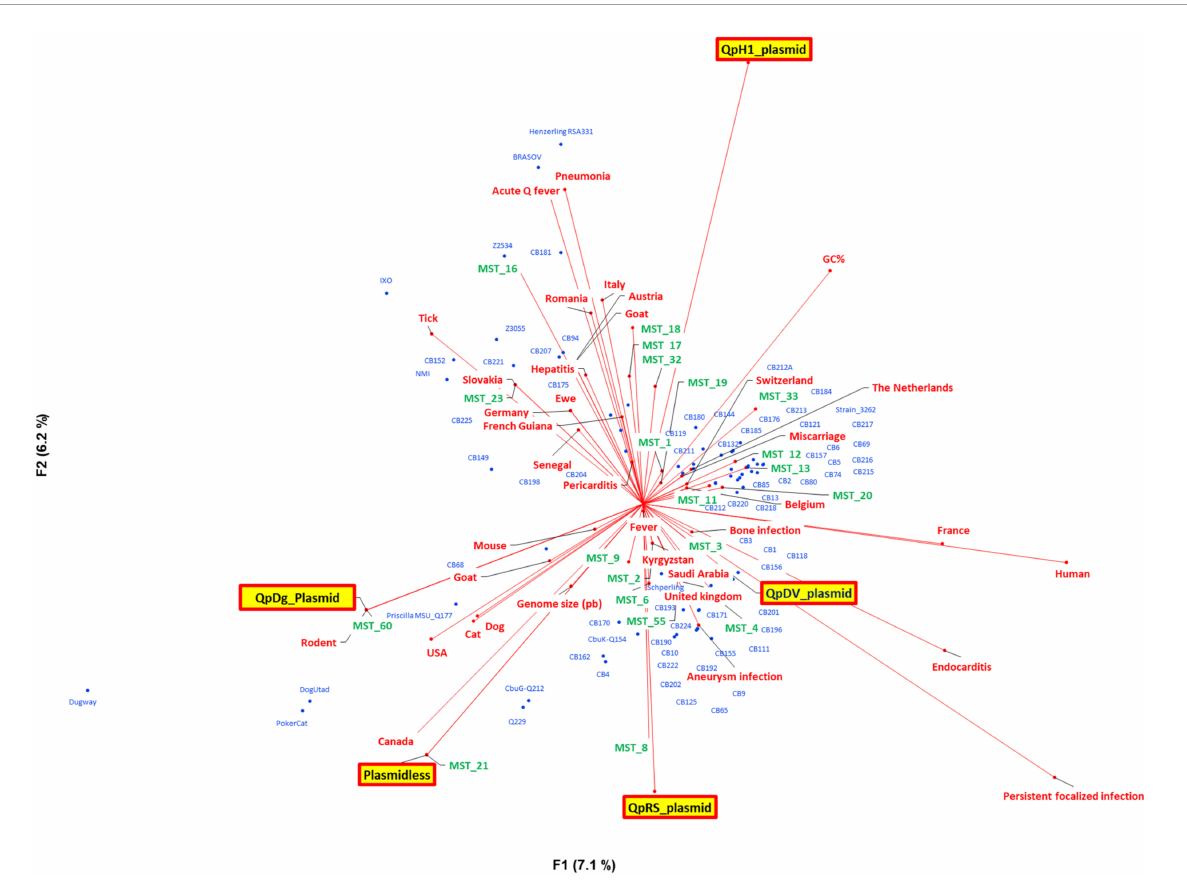
FIGURE5 Principal component analysis with genomic information [genome size, G + C content, multispacer sequence typing (MST), and plasmid type], geography, host, and clinical